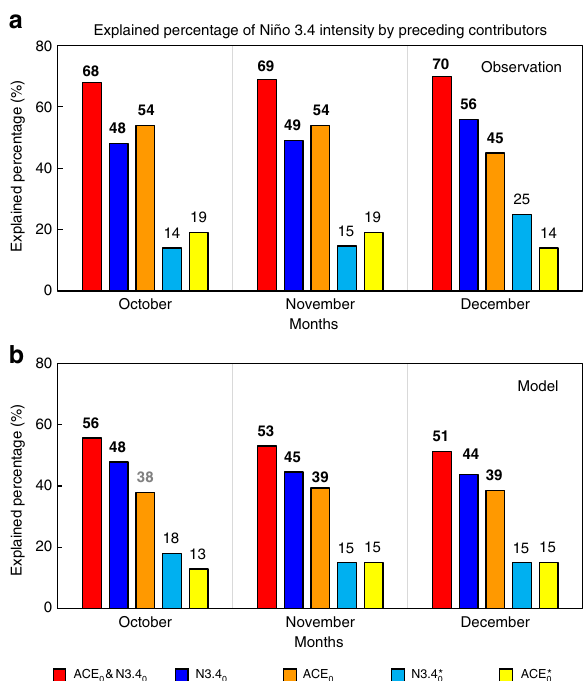
Fig. 1 Explained percentage (%) of the running 3-month mean SST anomaly for the Niño 3.4 region (5°N − 5°S, 120° − 170°W) (N3.4, an ENSO index) from October – December obtained using the preceding (3-months earlier) contributors ’ signals during El Niño developing years (1970 − 2016).